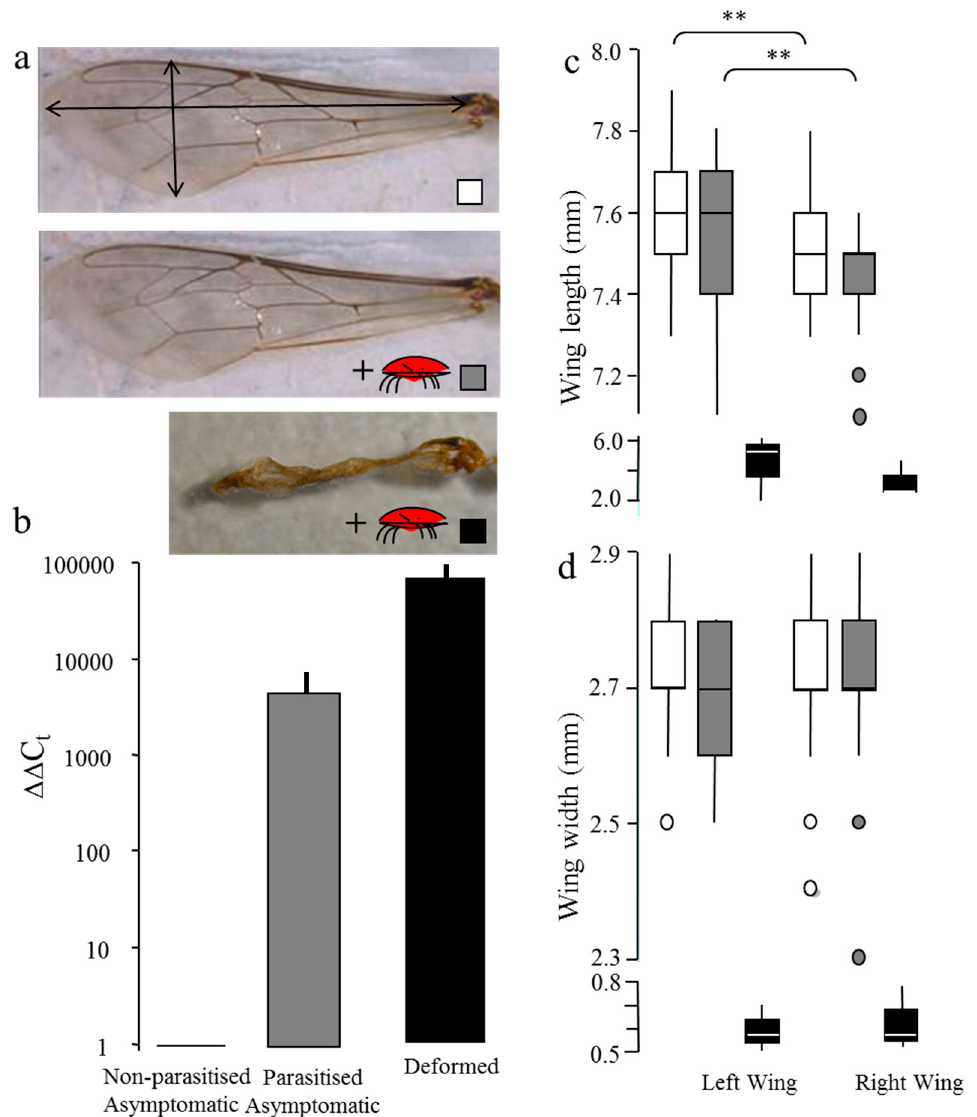
Figure 1. ( a ) Shows images of a normal forewing from a non-parasitised, parasitised asymptomatic, and a deformed honey bee; ( b ) Deformed wing virus (DWV) load of non-parasitised, parasitised asymptomatic, and deformed bees quantified by DWVQ RT-qPCR. Delta delta Cycle threshold (C t ) values normalised against an Actin gene control and non-parasitised asymptomatic bees; [11] and relative to the non-parasitised asymptomatic bees, shown on a log scale ( c ) wing length and ( d ) width of 45 non-parasitised (clear box blots), 45 parasitised (grey box plots) and three bees with deformed wings (black box plots). Note the broken axis to deal with the large size differences between deformed and normal forewings. ** p < 0.001 between right and left wings.